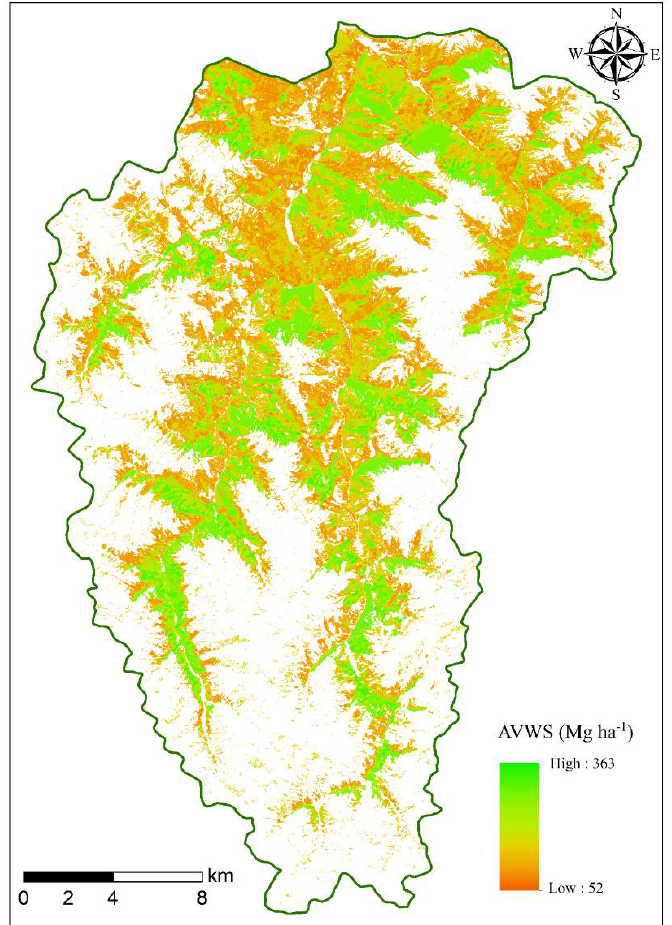
Figure 4. Modelled aboveground vegetation water storage (Mg ha − 1 ) in the Jiuzhaigou National Nature Reserve.